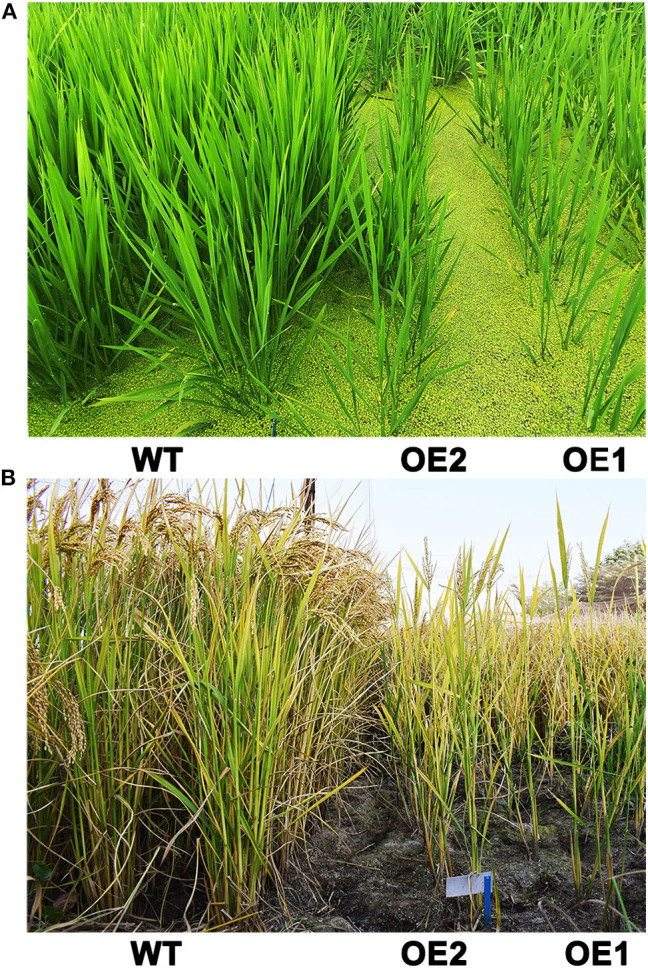
Phenotypes of OsCKX2 OE rice and WT in vegetative growth phase (A) and at mature stage (B) under field condition.